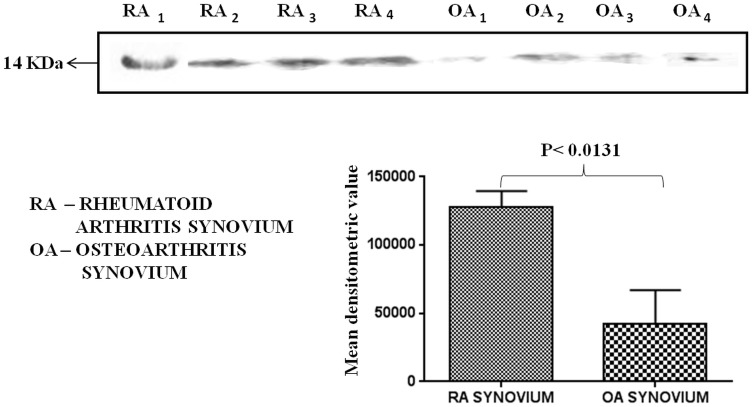
Quantitation of TTR in synovium by Western blotting.Protein (50 μg) of RA synovium (n = 7) and OA synovium (n = 7) was loaded in SDS-PAGE gels, the proteins were separated and transferred onto nitrocellulose. Western blot results revealed 3.2 fold higher expression (p<0.0131) of TTR in RA synovium as compared to OA synovium.